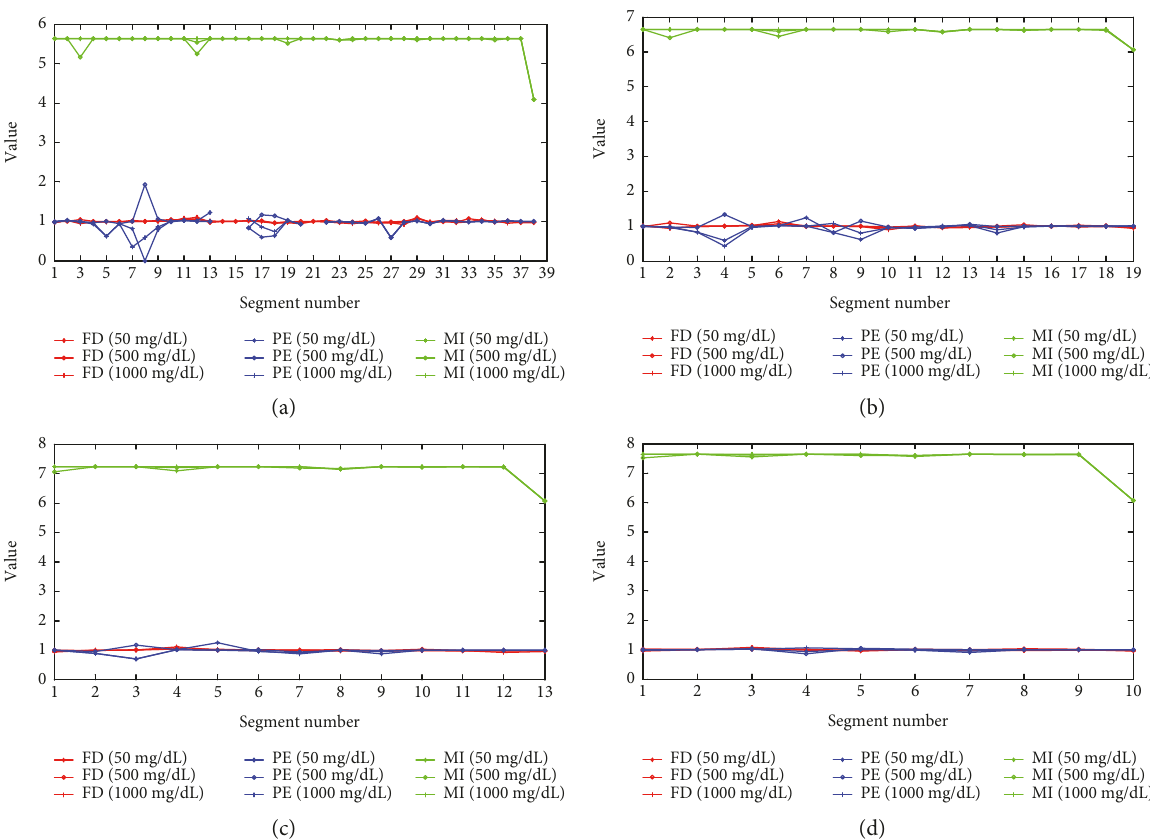
Figure 6: PE, FD, and MI of segmented spectral data: (a) 50 mg/dL, (b) 100 mg/dL, (c) 150mg/dL, and (d) 200mg/dL.